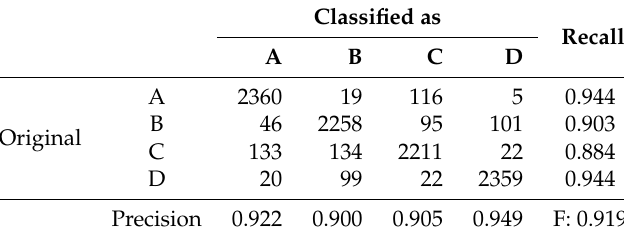
Table 4. Confusion matrix of label visibility classification with RandomForest